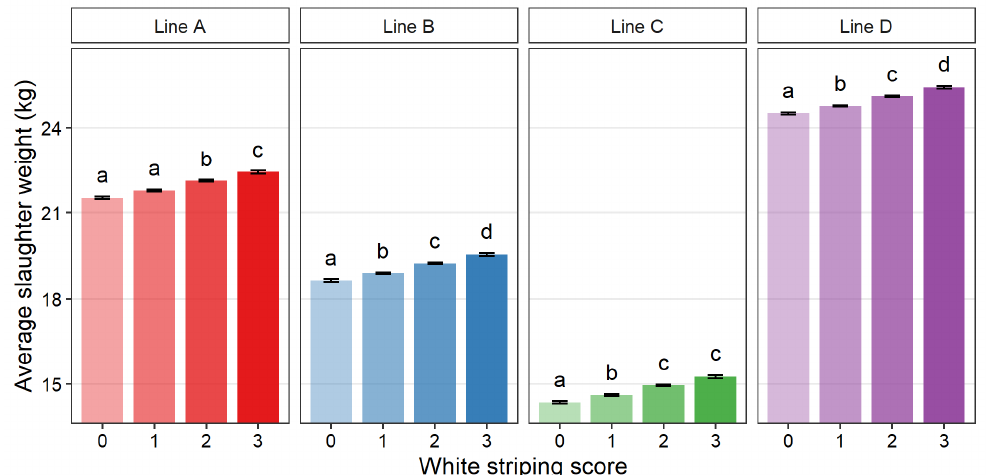
Figure 3. Least square means for slaughter weight (live weight of the bird 2 days prior to slaughter in kg) of purebred turkey toms for each white striping score (0–3) within each genetic line (A: n = 2834, B: n = 3715, C: n = 2032, D: n = 3701). Error bars show standard error. Means with different letters (a–d) within genetic line represent statistical significance ( p < 0.05) as determined by Tukey’s HSD test.